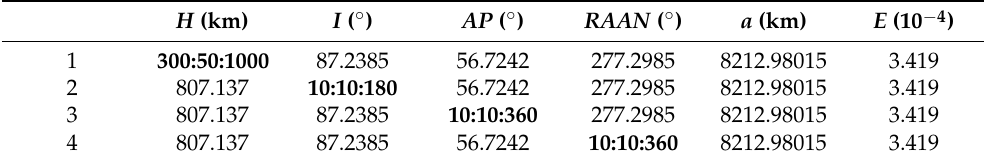
Table 1. Satellite orbit parameter settings.